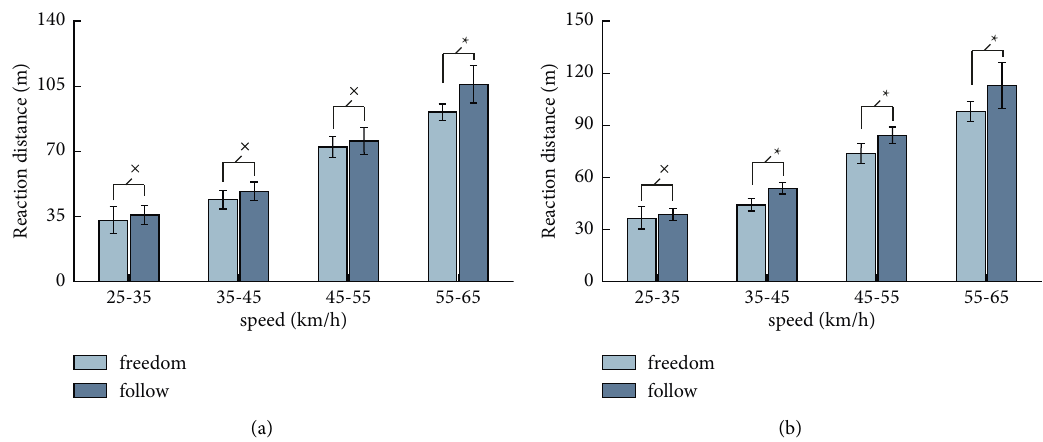
Figure 11: ANOVA results for traffic state on the second reaction distance. (a) Low density; (b) high